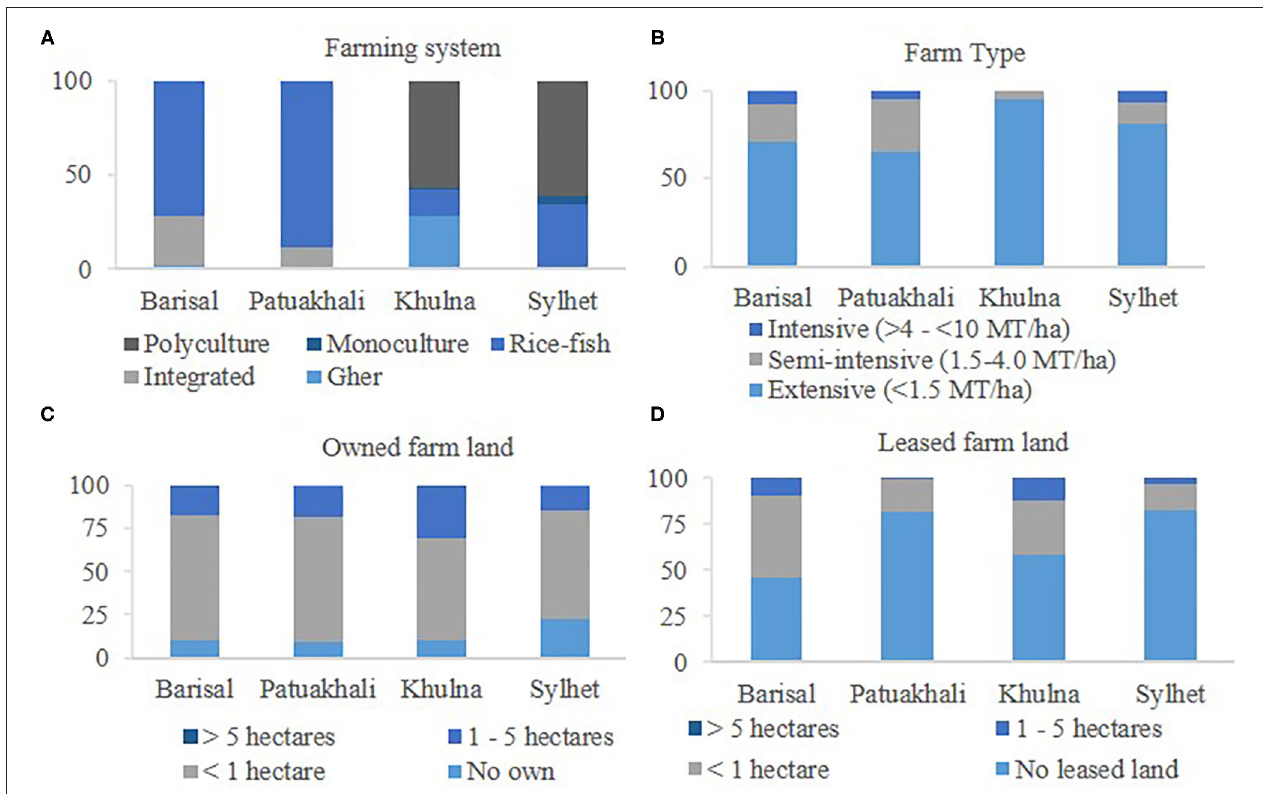
FIGURE 2 | Overview of fish-farming practice in the studied regions by percent of